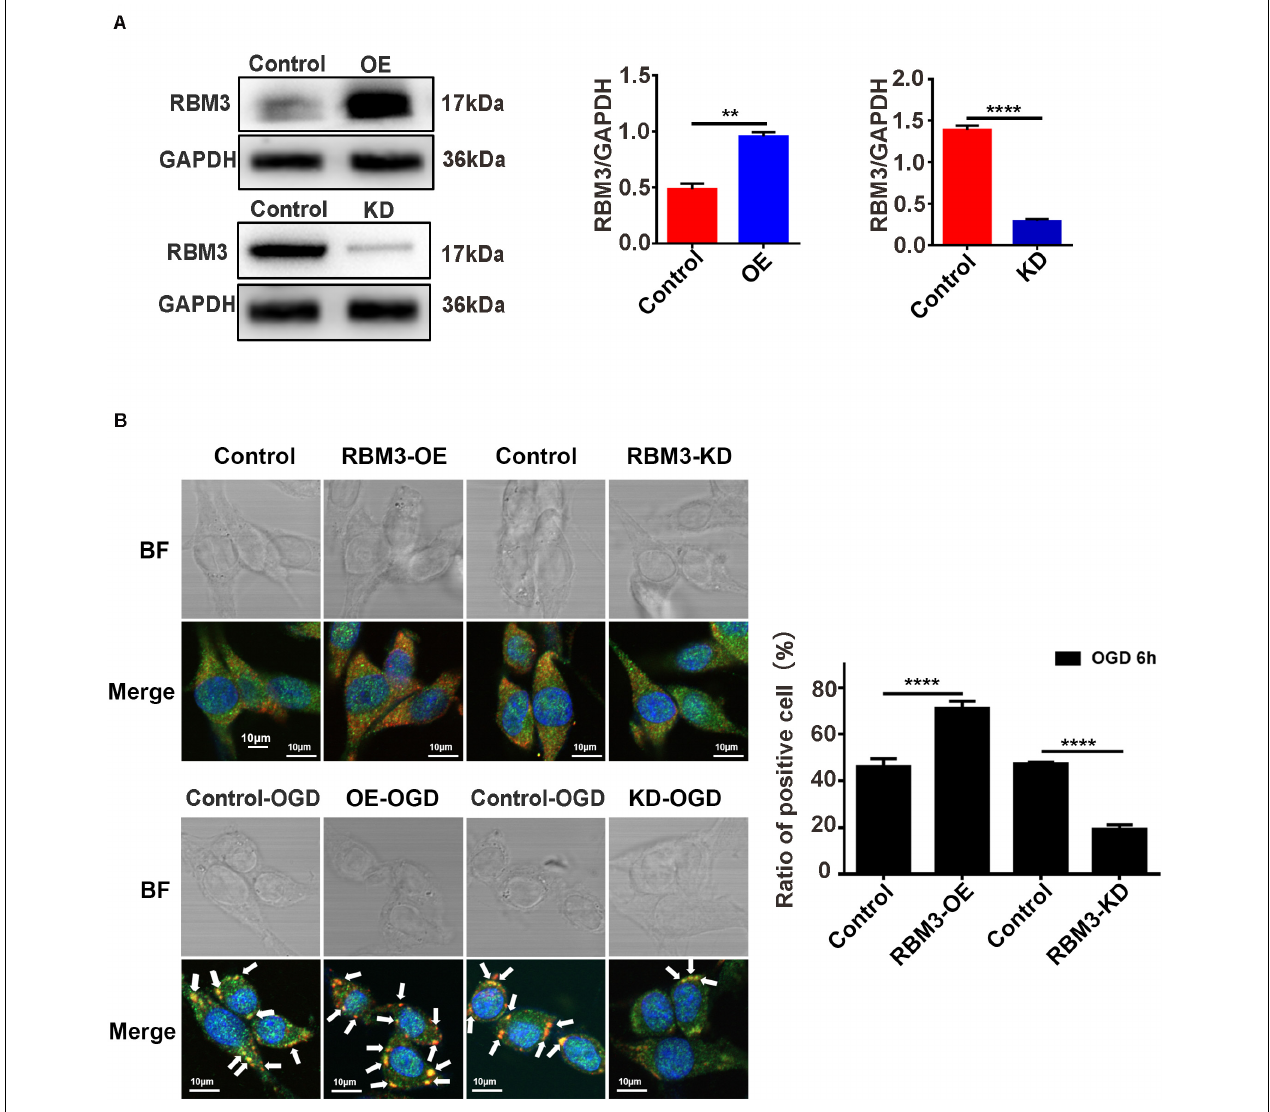
FIGURE 6 | RBM3 promotes SG formation in PC12 cells under OGD stimulation. (A) The efficiency of RBM3 knockdown or overexpression in PC12 cells. The efficiencies of RBM3 knockdown and overexpression were detected by western blotting ( **** , control vs. KD: P < 0.0001; ** , control vs. OE: P < 0.01). (B) SG formation in RBM3 knockdown or overexpression PC12 cells under OGD stimulation. SGs were detected with double-labeled immunofluorescence (TIA1 and G3BP1); the nucleus was labeled with DAPI (blue). Scale bars: 10 µ m. **** , compared with control group; P < 0.0001.